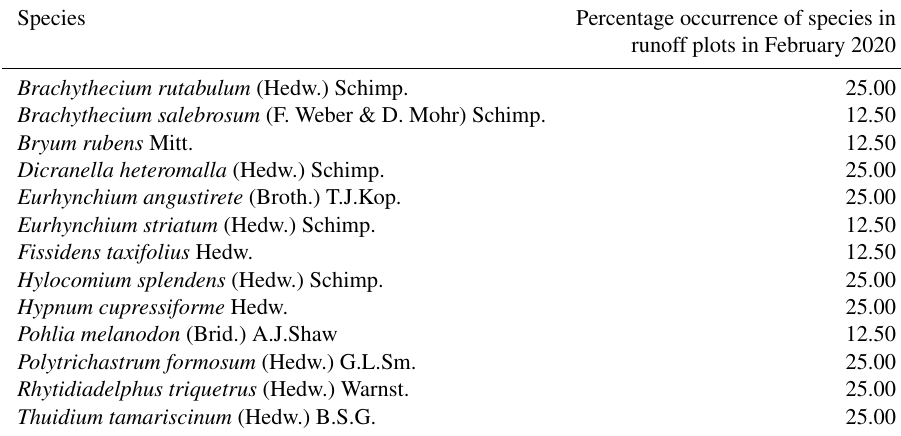
Table 2. Percentage occurrence of bryophyte species for a total of eight runoff plots in undisturbed forest soil in Schönbuch Nature Park in southwestern Germany, based on one vegetation survey in February